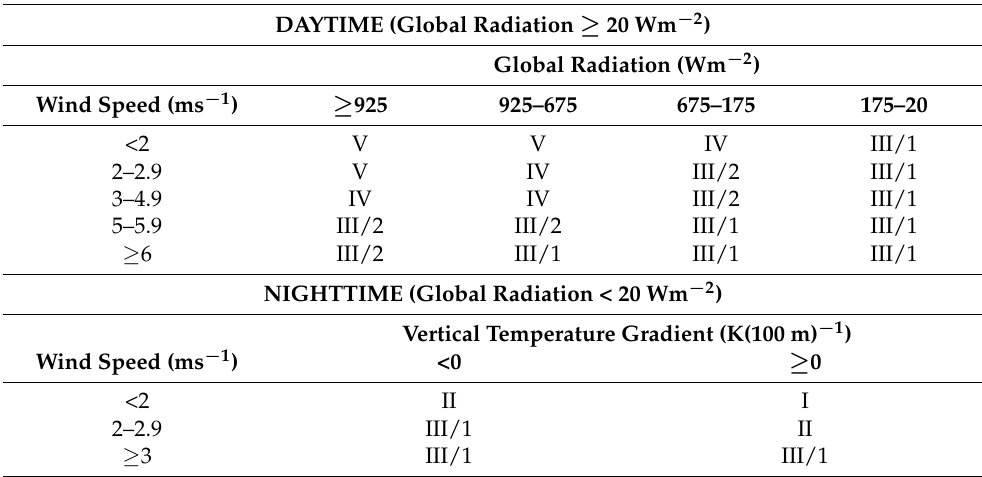
Table 1. Scheme to determine U.S. EPA stability classes (transformed to K-M classes).